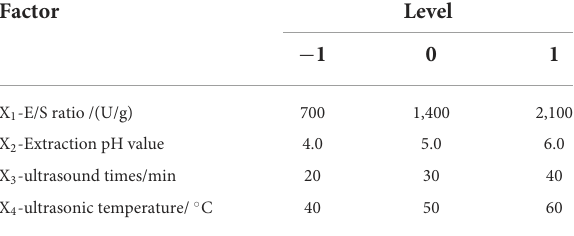
TABLE 1 The process parameters setting for LLPs extraction, according to Box-Benkhen design. Factor Level − 1